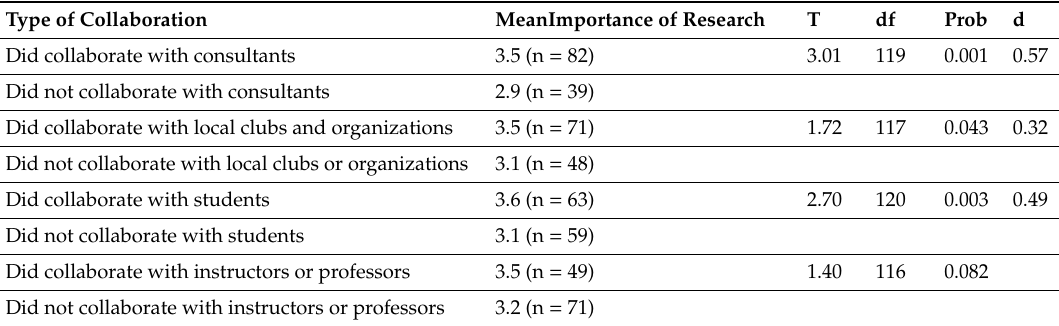
Table 4. The e ff ect of type of collaboration on the overall importance of